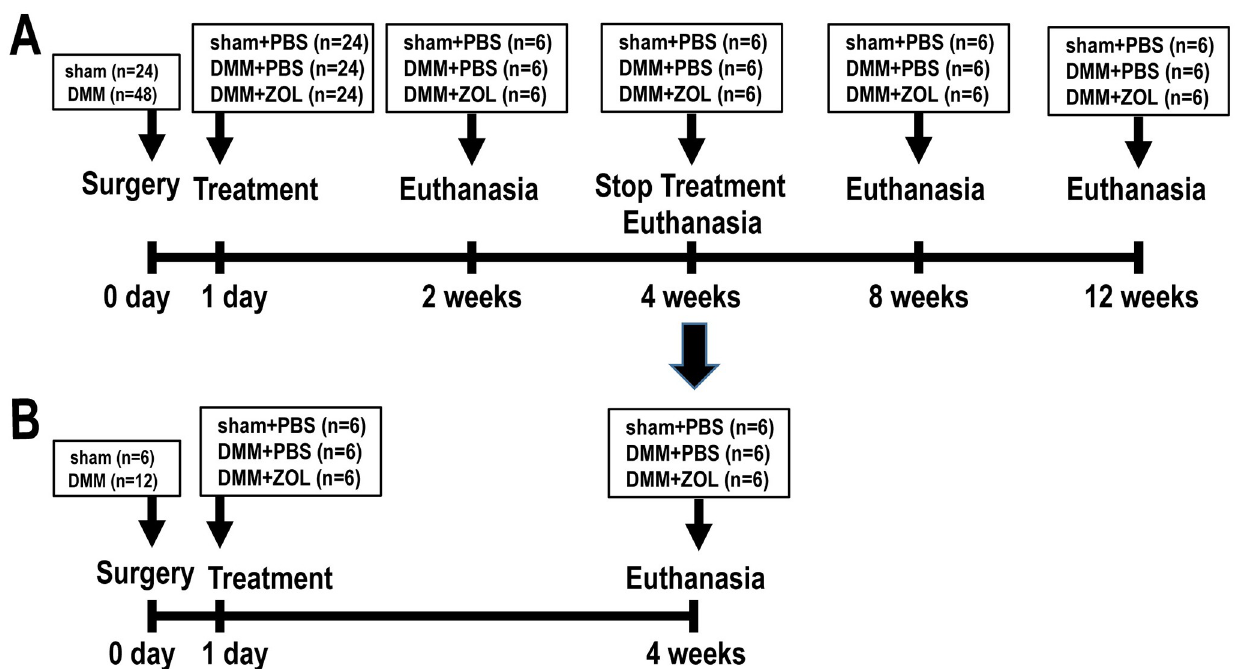
Fig 1. Schematic of the experimental design. (A) A total of 72 rats were randomly divided into sham+PBS, DMM+PBS, and DMM+ZOL groups at 2, 4, 8, and 12 weeks after OA induction (n = 6 per time point). The bone resorption stage of OA was identified, and effects of ZOL on cartilage and subchondral bone were assessed. (B) Another 18 rats were randomly divided into three groups at 4 weeks after OA induction (n = 6 per group) to explore possible molecular mechanism of osteoclast activation in early